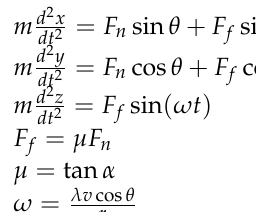
where m is the weight of the soil particle (kg), F n is the acting force of soil particles perpendicular to the disk plane (N), F f is the friction between the particle and the disk (N), θ is the dip angle between the disk surface and the forward direction of planter motion ( ◦ ), µ is the dynamic friction factor between soil and disk, α is the friction angle between soil particles ( ◦ ), ω is the angular speed of disk rotation (rad/s), λ is the speed coefficient of angular speed, and v is the walking speed of the sugarcane planter (m/s).